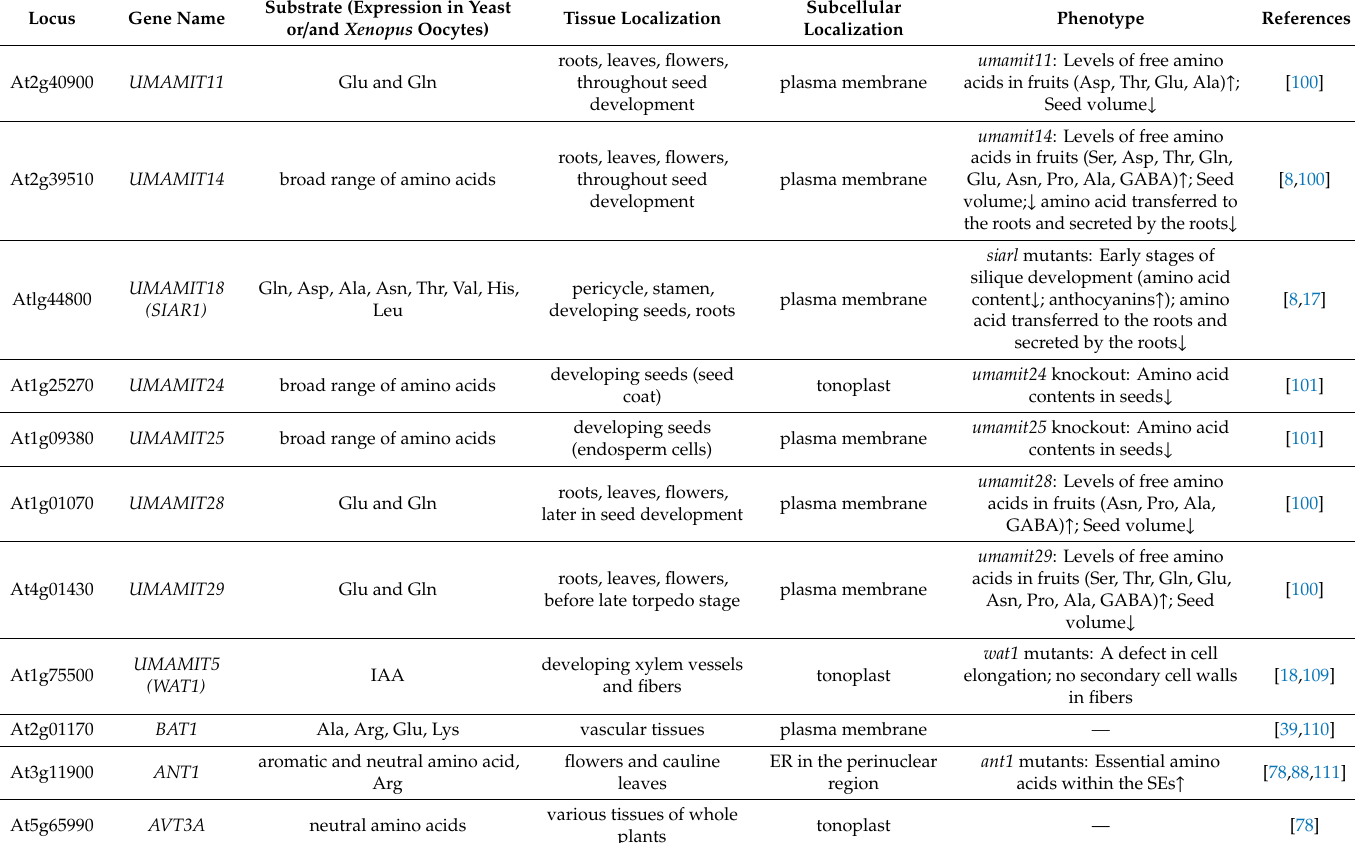
Table 1. Overview of amino acid exporters in